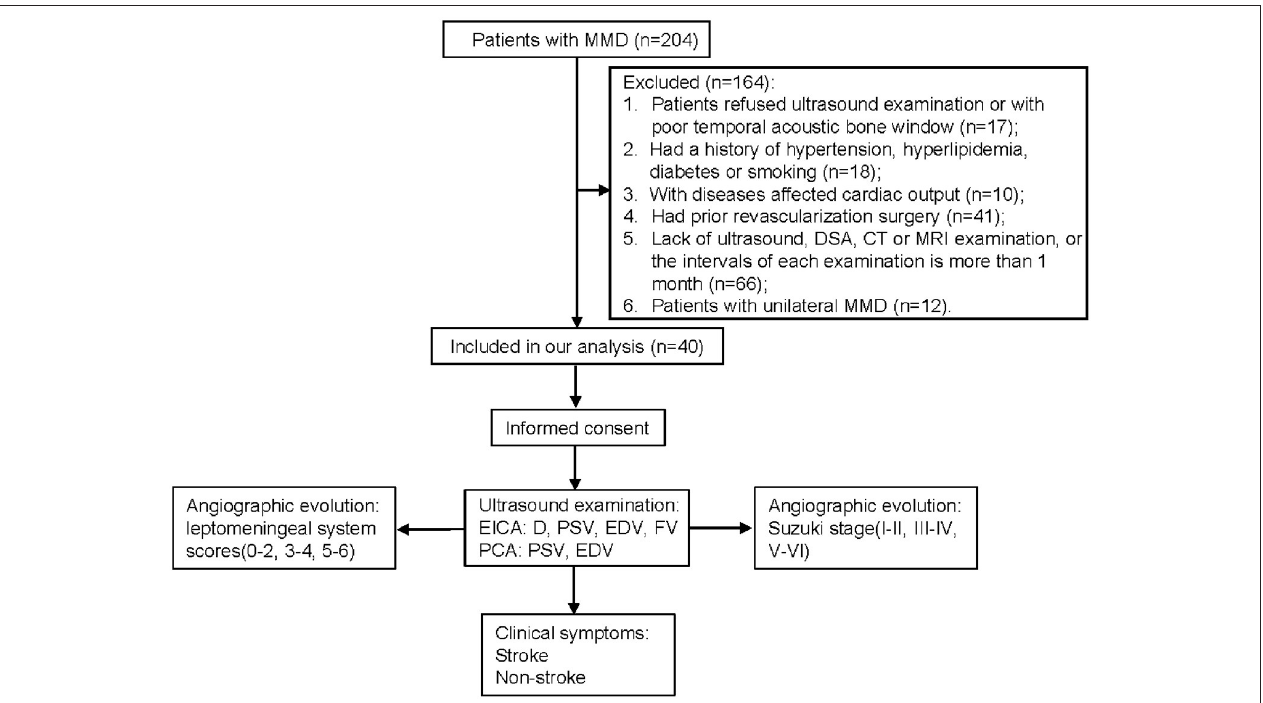
FIGURE 1 | Flow diagram of the study. MMD, moyamoya disease; DSA, digital subtraction angiography; CT, computed tomography; MRI, magnetic resonance imaging; EICA, extracranial internal carotid artery; D, diameter; PSV, peak systolic velocity; EDV, end diastolic velocity; FV, flow volume; PCA, posterior cerebral